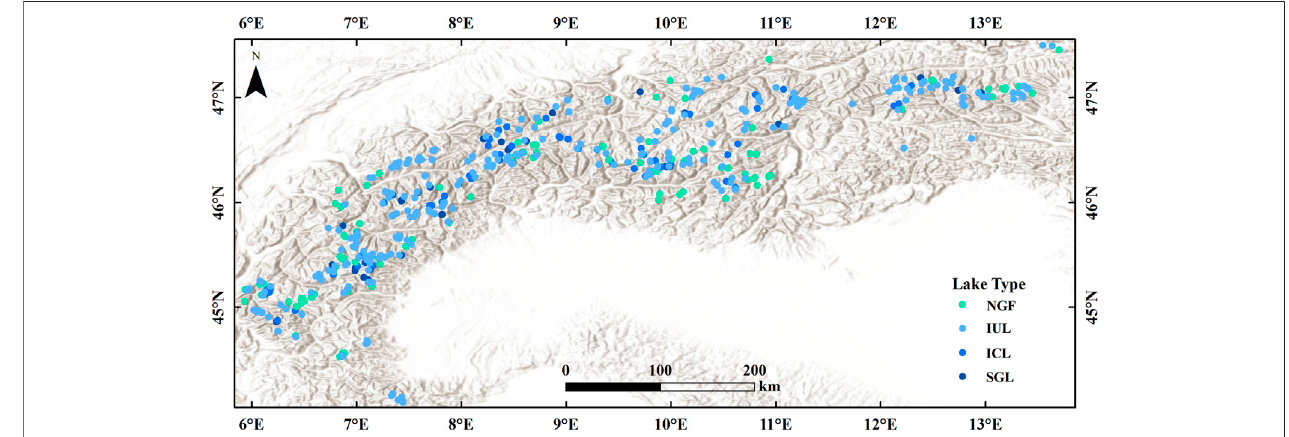
FIGURE 2 | Spatial distribution of four types of glacial